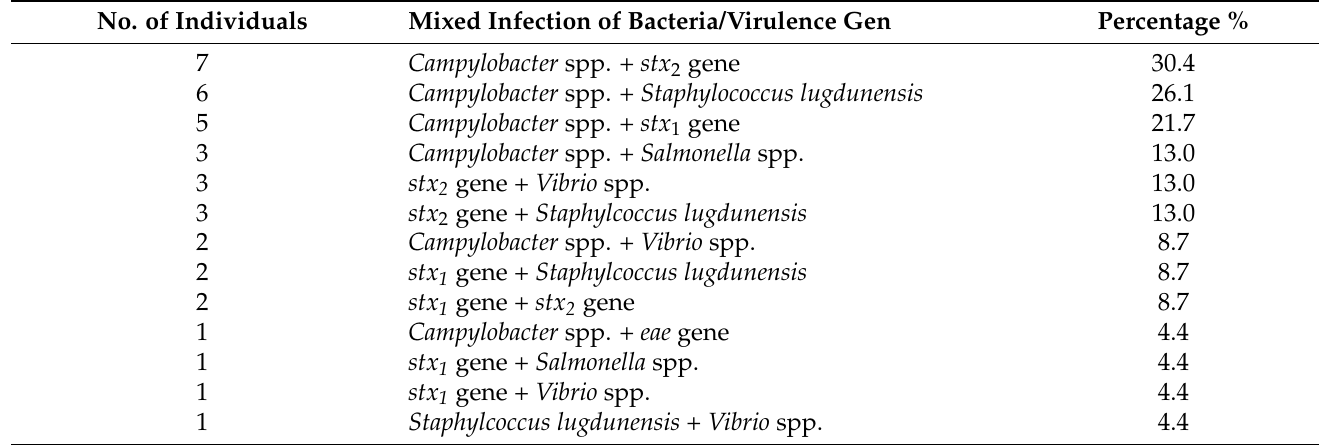
Table 4. Percentage of co-infections of pathogen bacteria isolated from Anolis sp. from Tenerife (Canary Islands, Spain) (n =